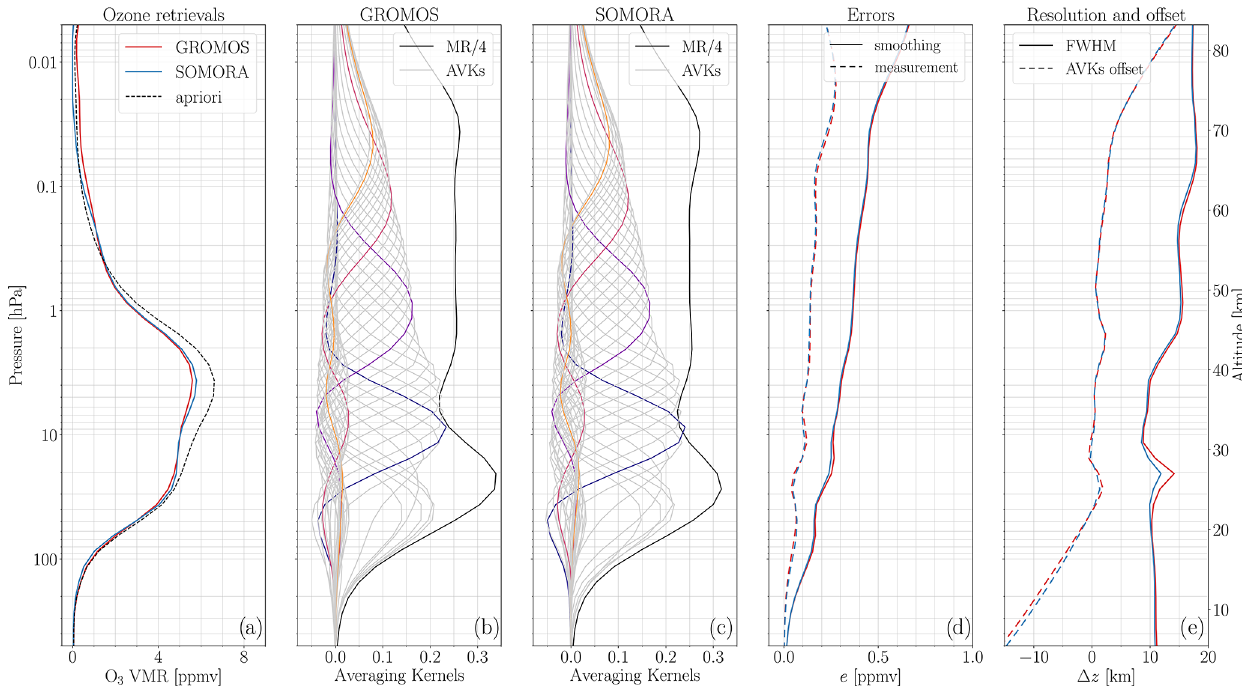
Figure 3. Example of GROMOS and SOMORA hourly ozone retrievals on 9 January 2017 around 14:30UT with a tropospheric opacity τ ≈ 0 . 4: panel (a) shows the a priori and retrieved ozone profiles, panels (b) and (c) show the GROMOS and SOMORA averaging kernels together with their MR (divided by 4 to fit in the same plots), panel (d) shows the smoothing and measurement error, and panel (e) shows the full width at half maximum (FWHM) and the offset between the AVKs peak and the actual altitude contribution. All quantities are retrieved on pressure levels, and approximated altitudes are indicated on the right. See the text for more details on each diagnostic quantity.